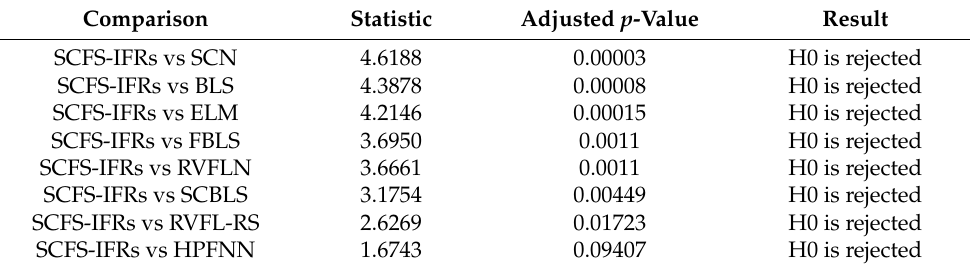
Table 6. Result of Holm post-hoc tests (significance level of 0.10).